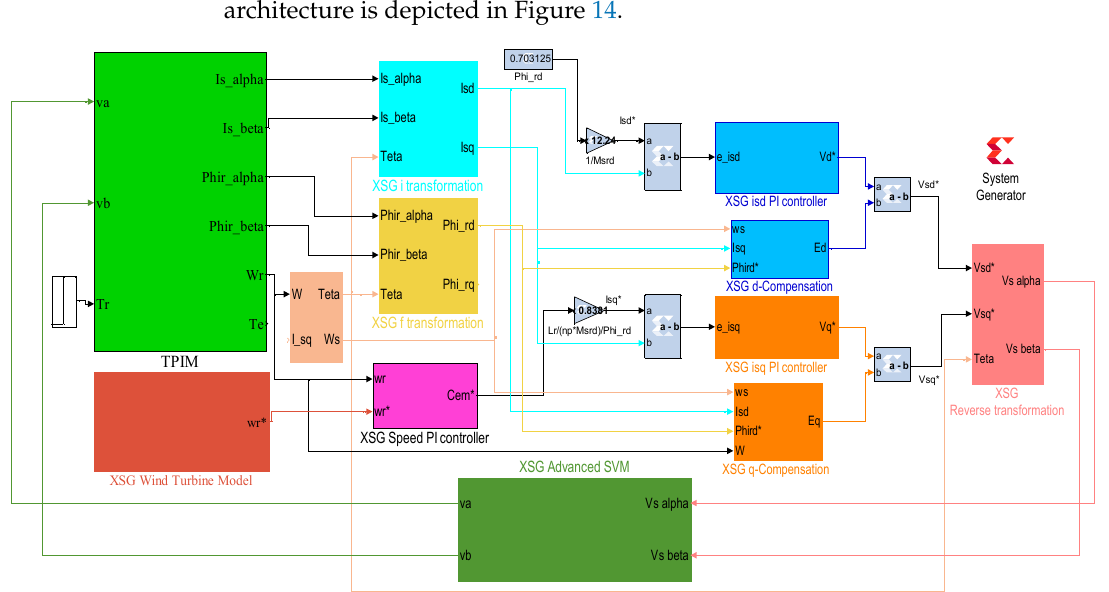
Figure 14. XSG architecture of the WTE controller.